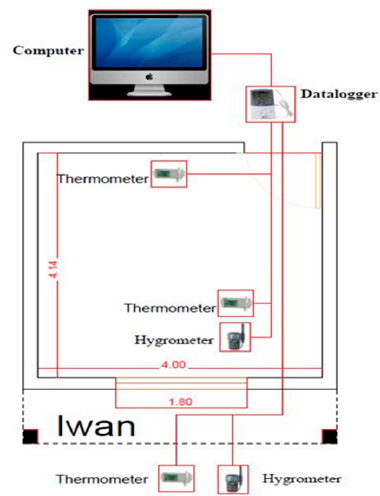
Figure 4. Schematic of experimental testing.